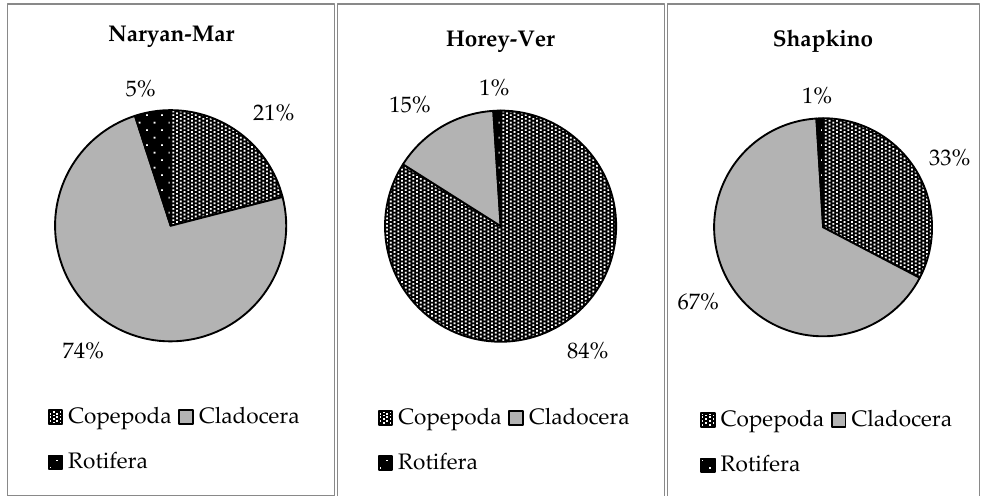
Figure 3. Contribution of major zooplankton groups to the total biomass in zooplankton communities of various sites (August 2016).